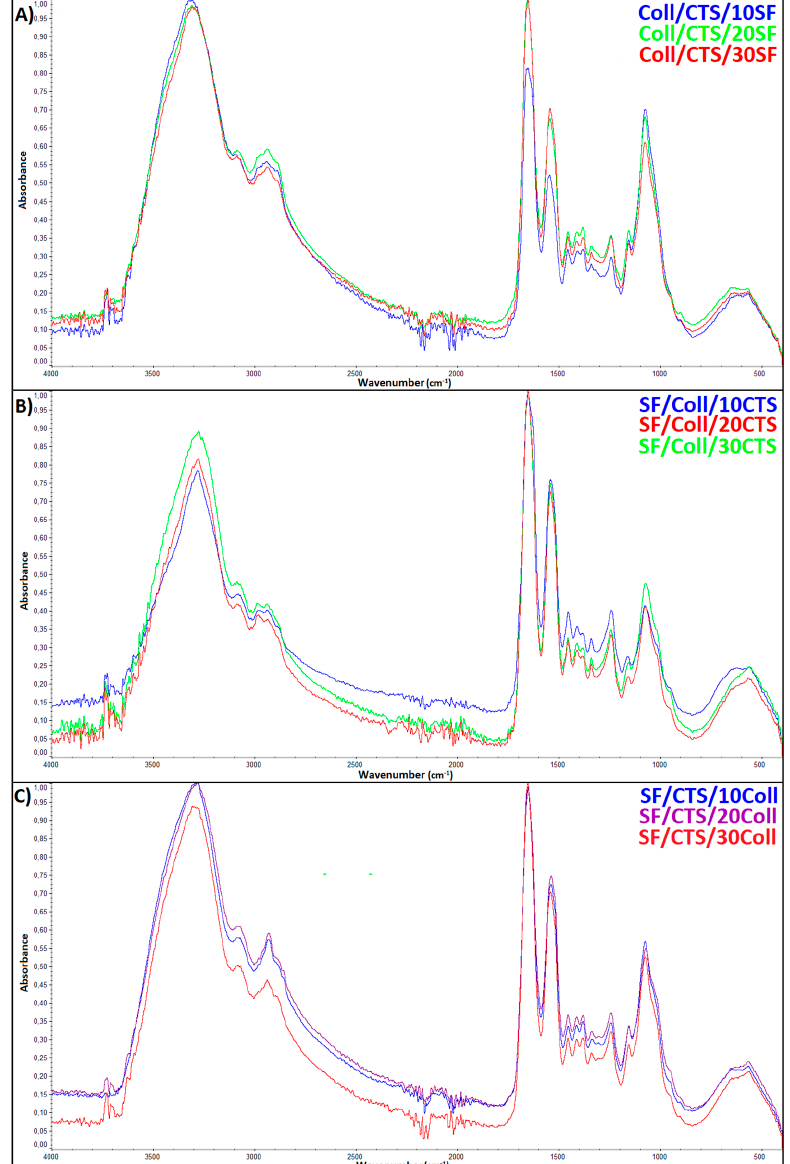
Figure 1. The ATR-FTIR spectra of the three-component scaffolds cross-linked by glyoxal solutions: ( A ) Coll/CTS mixture with 10, 20, and 30% SF; ( B ) SF/Coll mixture with 10, 20, and 30% CTS; and ( C ) SF/CTS with 10, 20 and 30% Coll.